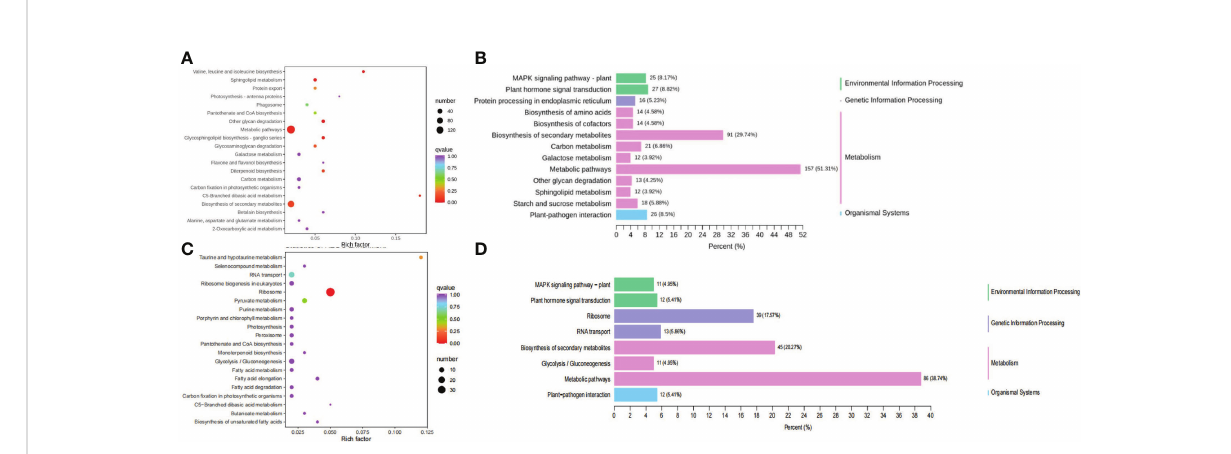
FIGURE 3 KEGG analysis of the DEGs from cluster 3 and 12. (A) KEGG classi fi cation of the DEGs from cluster 3. (B) KEGG enrichment analysis of the DEGs from cluster 3. (C) KEGG classi fi cation of the DEGs from cluster 12. (D) KEGG enrichment analysis of the DEGs from cluster